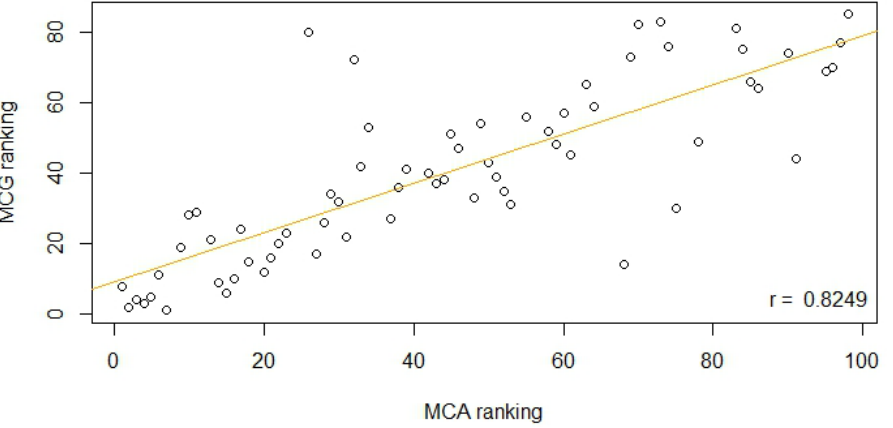
Figure 2. A plot of ranks of candidates selected for whole-genome sequencing using the MCA or MCG methods, respectively